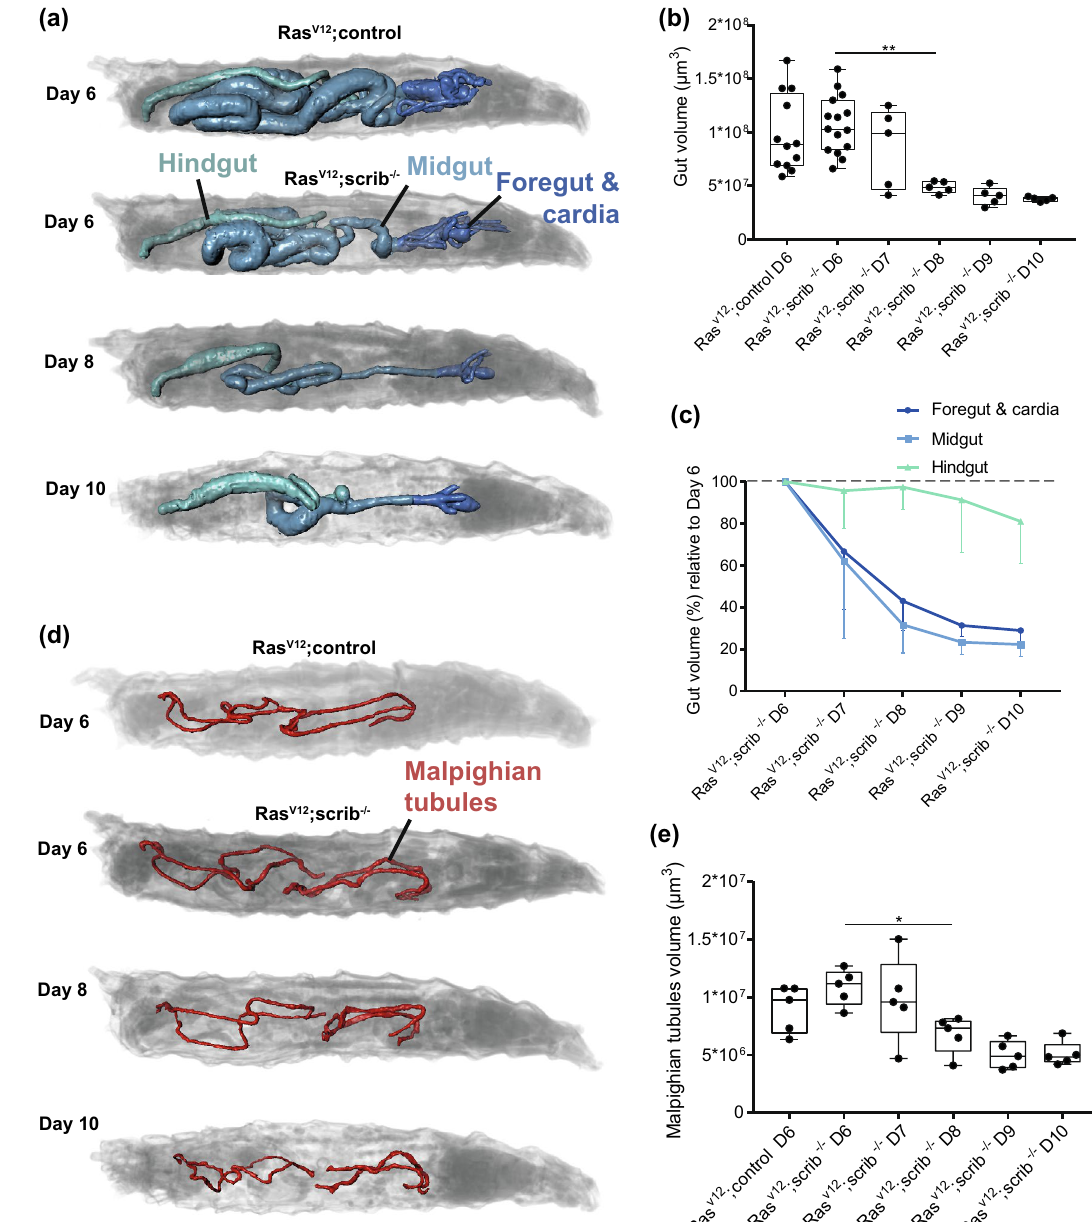
Figure 3. The foregut and cardia, midgut and Malpighian tubules all demonstrate reduced organ volume during cachexia. ( a ) Illustration of the gut segments in a control larvae or with a tumor at several time-points. Foregut (esophagus) and cardia are measured as one unit and shown as dark blue, midgut (small intestine) in light blue and hindgut (large intestine) is shown in teal. ( b ) Quantification of total gut volume for all samples. ( c ) Volumes of the three distinct parts of the gut quantified separately and shown relative to the day 6 measurements. ( d ) Illustration of Malpighian tubules (kidneys). ( e ) Malpighian tubules volumes shown for all samples. The indicated statistical tests are one-way ANOVA with a Turkeys’s multiple comparisons test. *p < 0.05. **p < 0.01. Shown images are of representative larvae. Quantifications in ( b ) have n = 15 for Ras V12 ;control D6 and Ras V12 ;scrib −/− D6 and n = 5 for the remaining samples of that graph. Quantifications in ( c ) and ( e ) are of n = 5